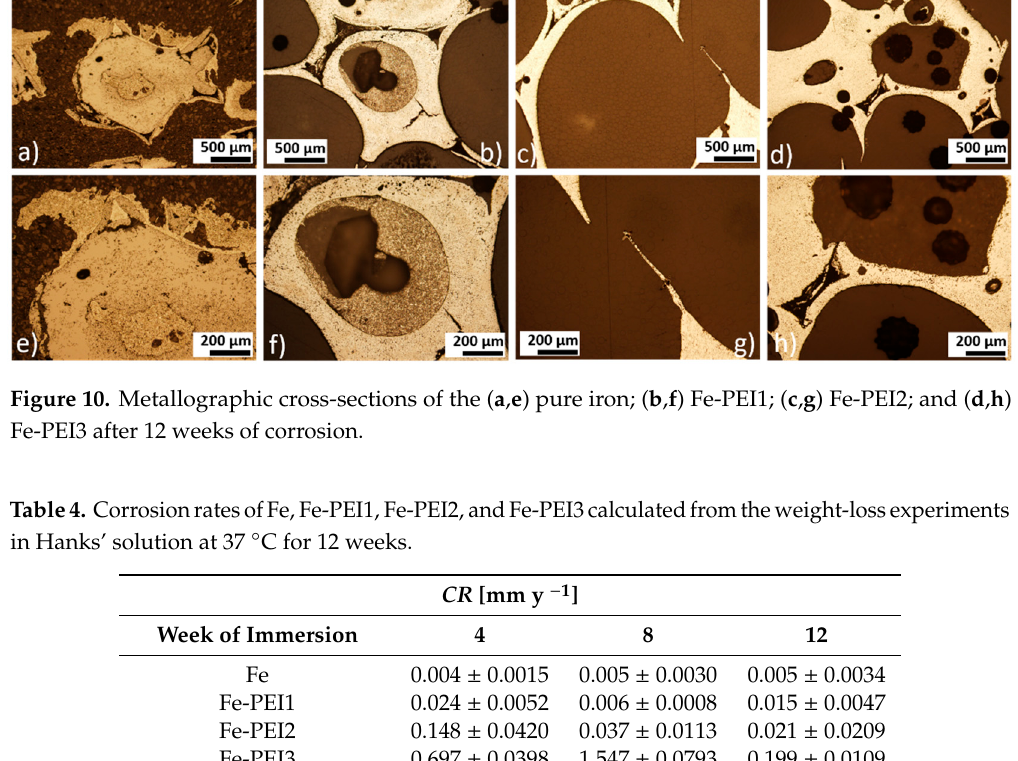
after 12 weeks of corrosion in the Hanks´ solution at 37 °C. Materials 2020 , 13 , x FOR PEER REVIEW